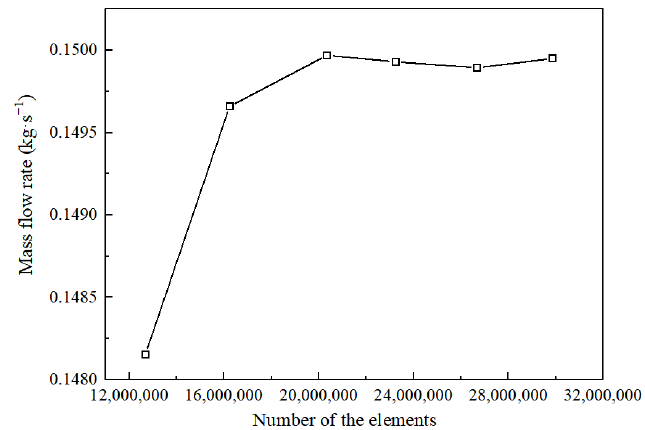
Figure 8. Grid independence verification of the CFD model.